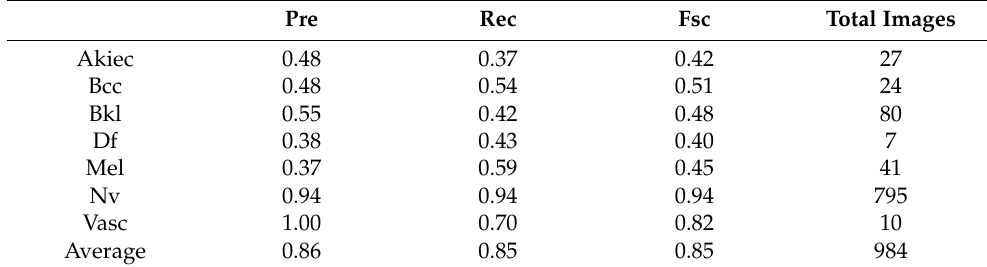
Table 6. Detailed results for each class using modified Resnet-50 learning model.